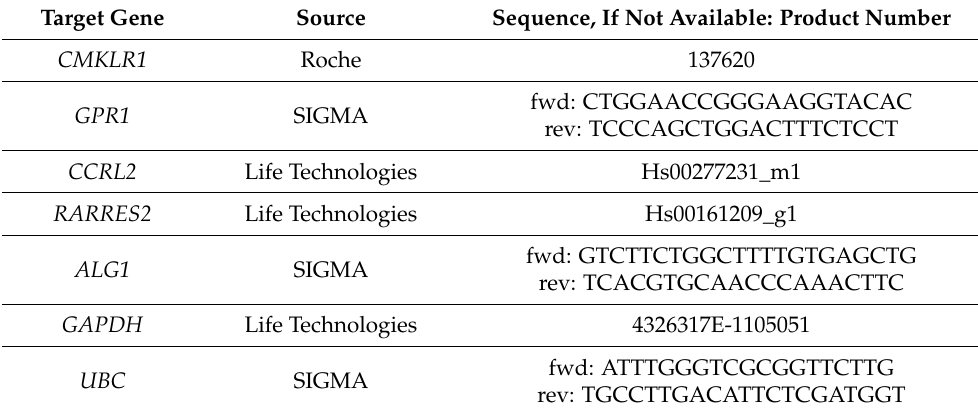
Table 1. Oligonucleotide primer information (fwd: forward, rev: